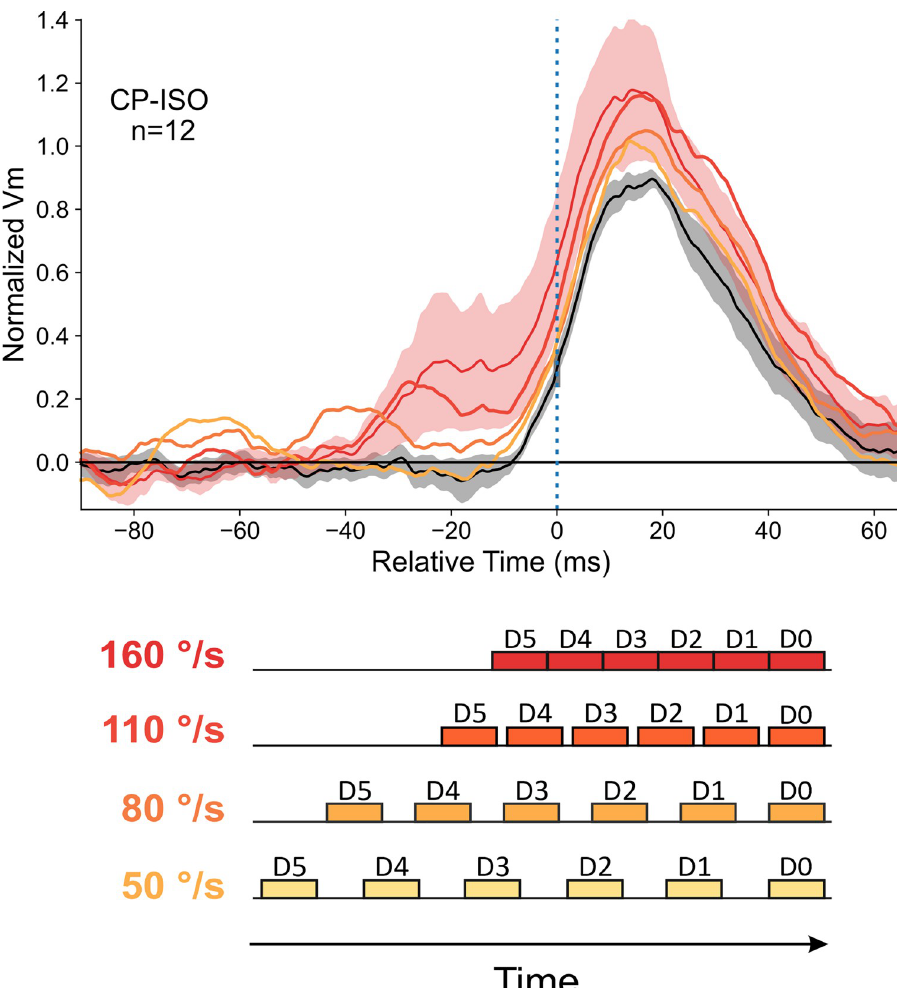
Fig 11. Dependency of the contextual effect on the speed of the AM flow. Bottom, the chronograms depict the 4 inter-stroke interval conditions used in each cell to probe the temporal dependency of the interaction between the horizontal and the feedforward synaptic waves (color code reddens with speed value). The exact value of the “optimal” reference speed (100%) is defined on a cell-by-cell basis. Mean speed values, averaged across cells (n = 12), are given left of each chronogram. Top, population averages for the CP-ISO SECTOR condition. All individual responses are realigned with the Center-Only response onset. The color-coded overlaid waveforms, averaged across cells, allow the comparison of the time-course of the response for the optimal speed value (red) and its S.E.M. envelope (shaded red) with that observed for various proportional reductions of the AM flow speed (from top to bottom: 70% (dark orange), 50% (orange) and 30% (light orange)). The contextual response modulation amplitude decreases proportionally to the AM speed reduction from its optimal